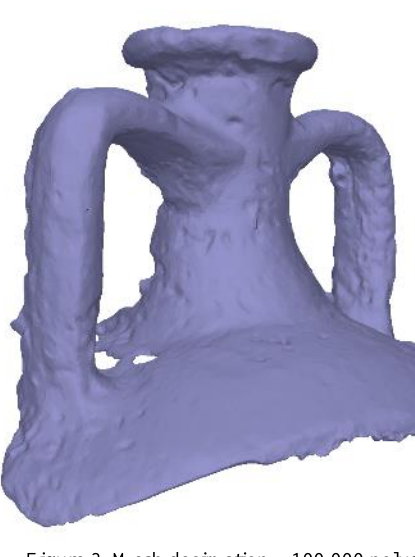
Figure 3. Mesh decimation – 100,000 polygons